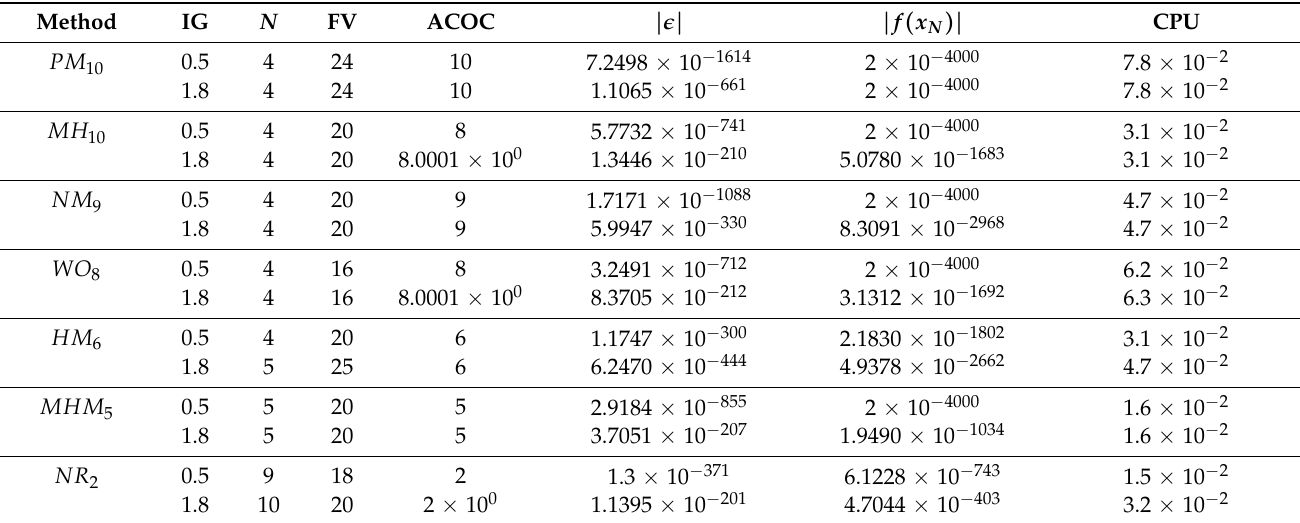
Table 9. Numerical results for problem 4.